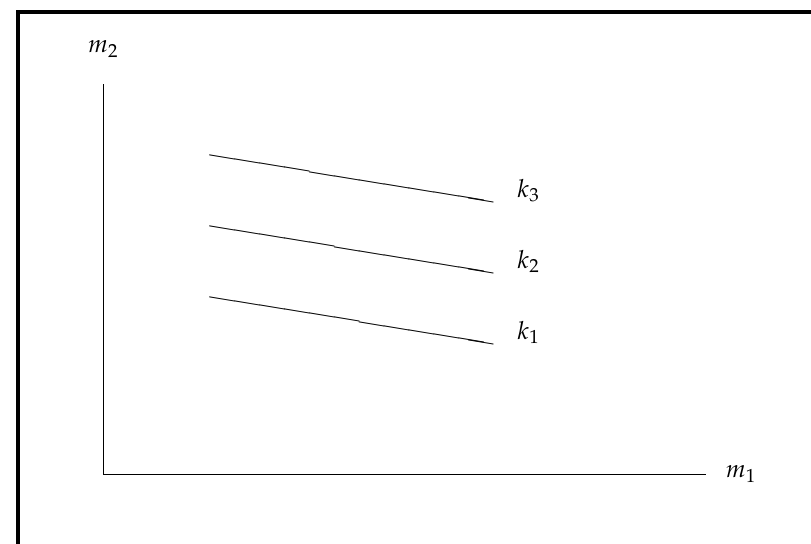
Figure 6. Indifference lines (case in which I =